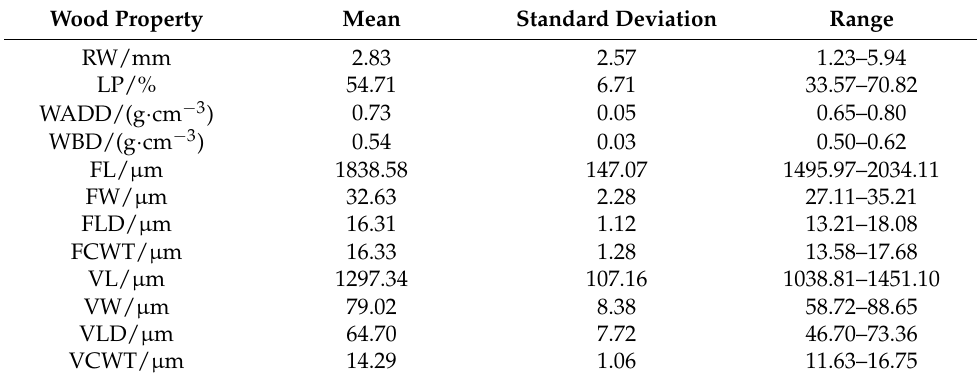
Table 3. Statistics analysis of wood properties in 54-year-old S. superba